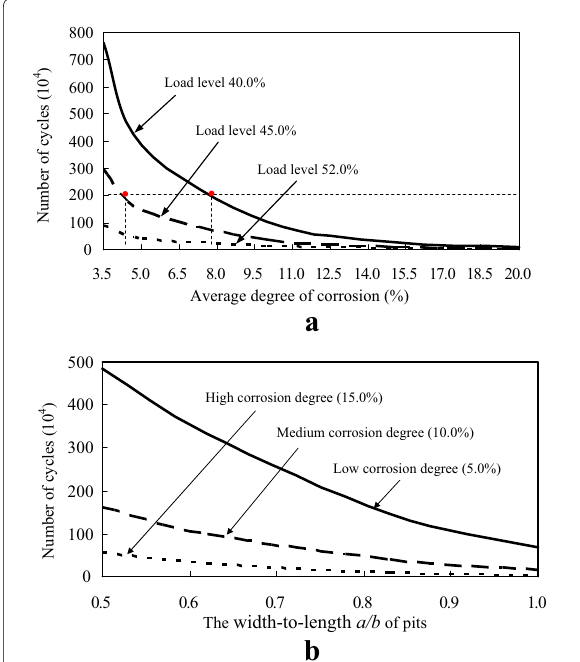
Fig. 13 Normalized ultimate strength degradation versus number of cycles: a a/b 0.62, b a/b = =